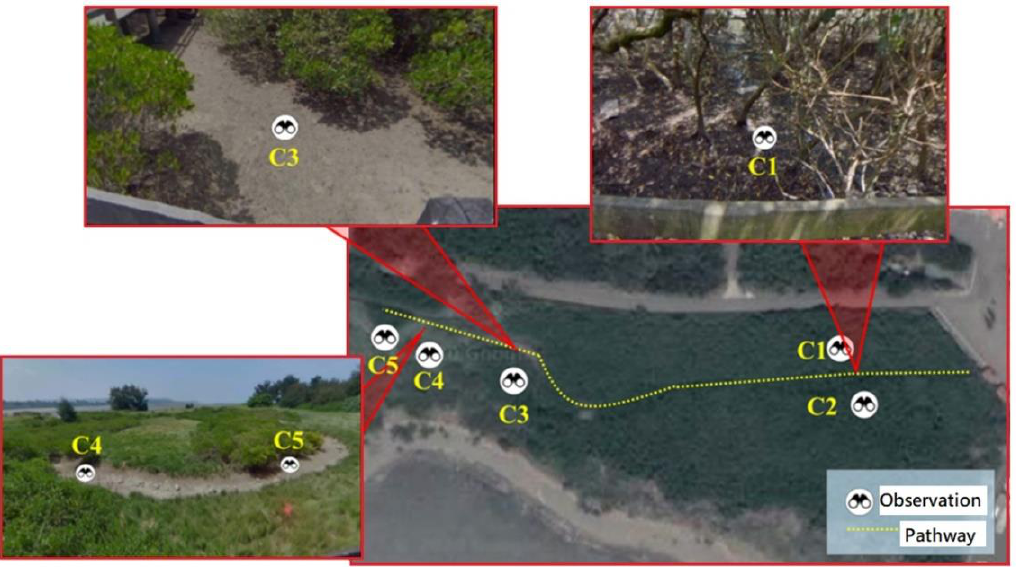
Figure 5. Shin Feng mangrove forest and its observation points. Table 4. Shin Feng mangrove forest and its creatures’ characteristics, food sources and functions. Wetland Creatures Characteristics and Food Sources